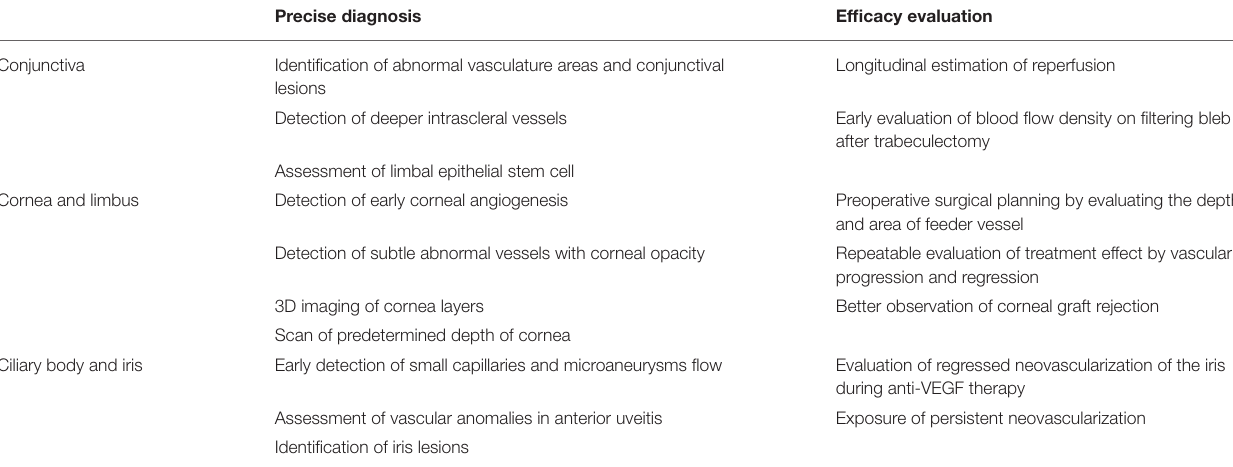
TABLE 1 | Advantages and applications of AS-OCTA. Precise diagnosis Efficacy